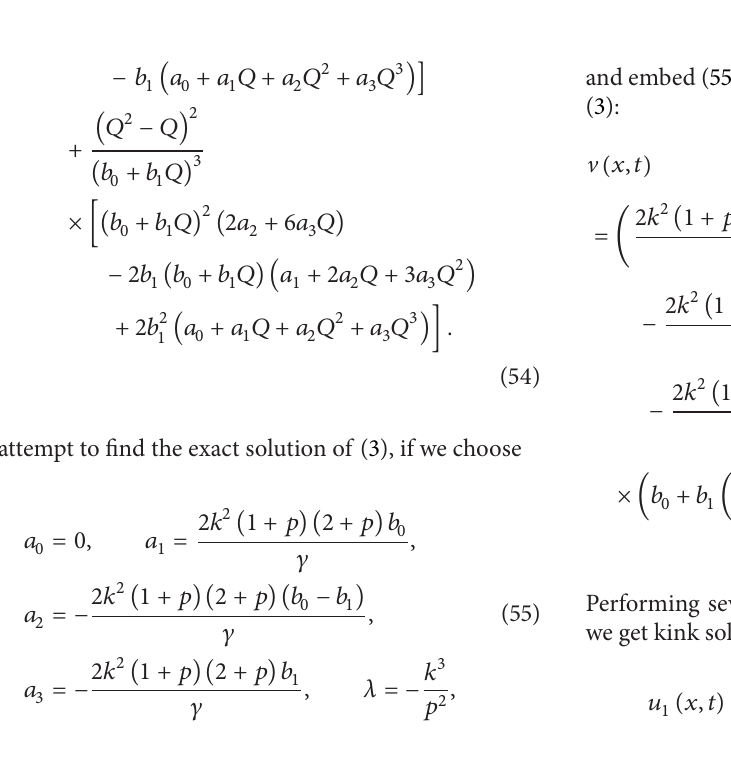
Figure 16: Two-dimensional graph of the solution (57) corresponding to the values 𝛼 = 0.05 , 𝛼 = 0.85 , respectively, when 𝑘 = 1 , 𝑝 = 2 , 𝛾 = 3 , 𝑡 = 1 , and −15 < 𝑥 < 15